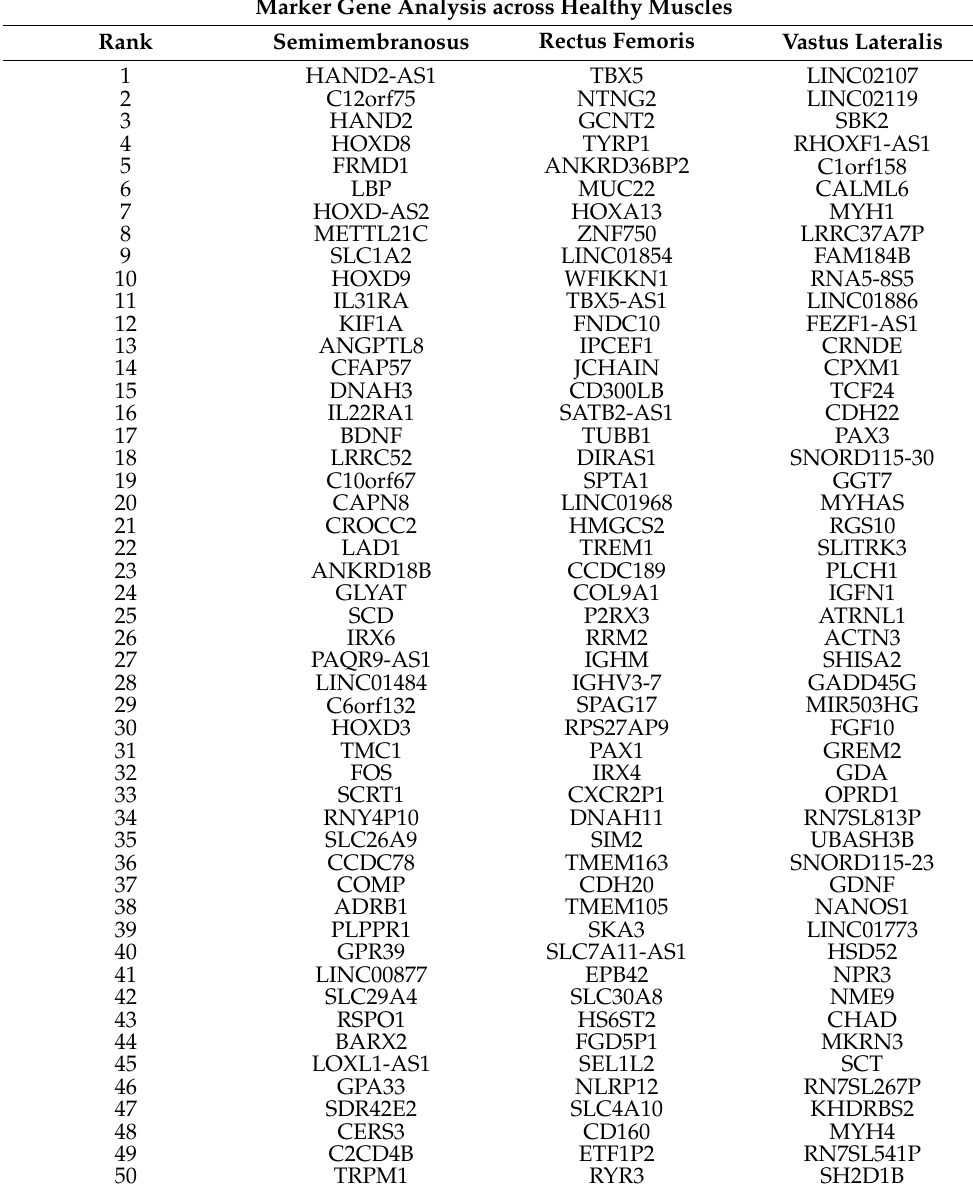
Table 2. Top 50 of most differentially expressed genes across healthy